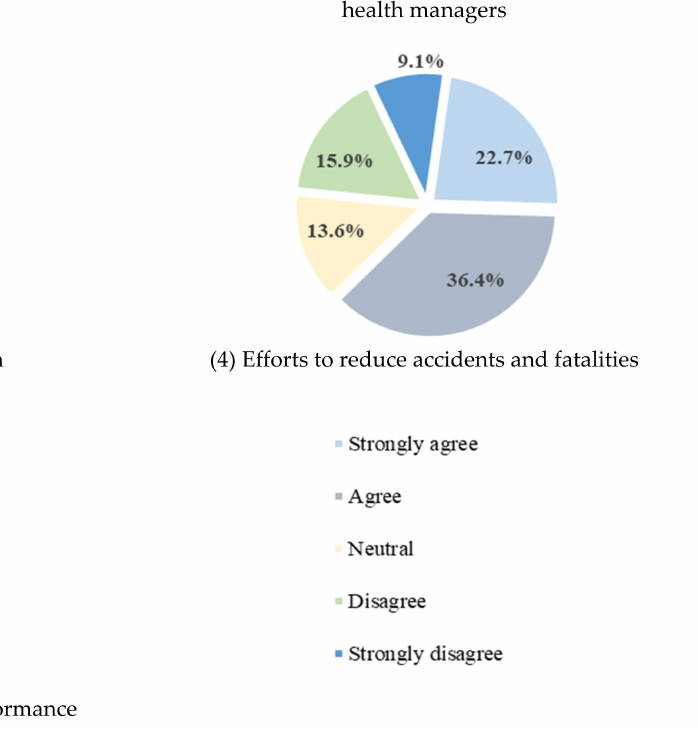
Figure 12. Survey results for each item improvement model.